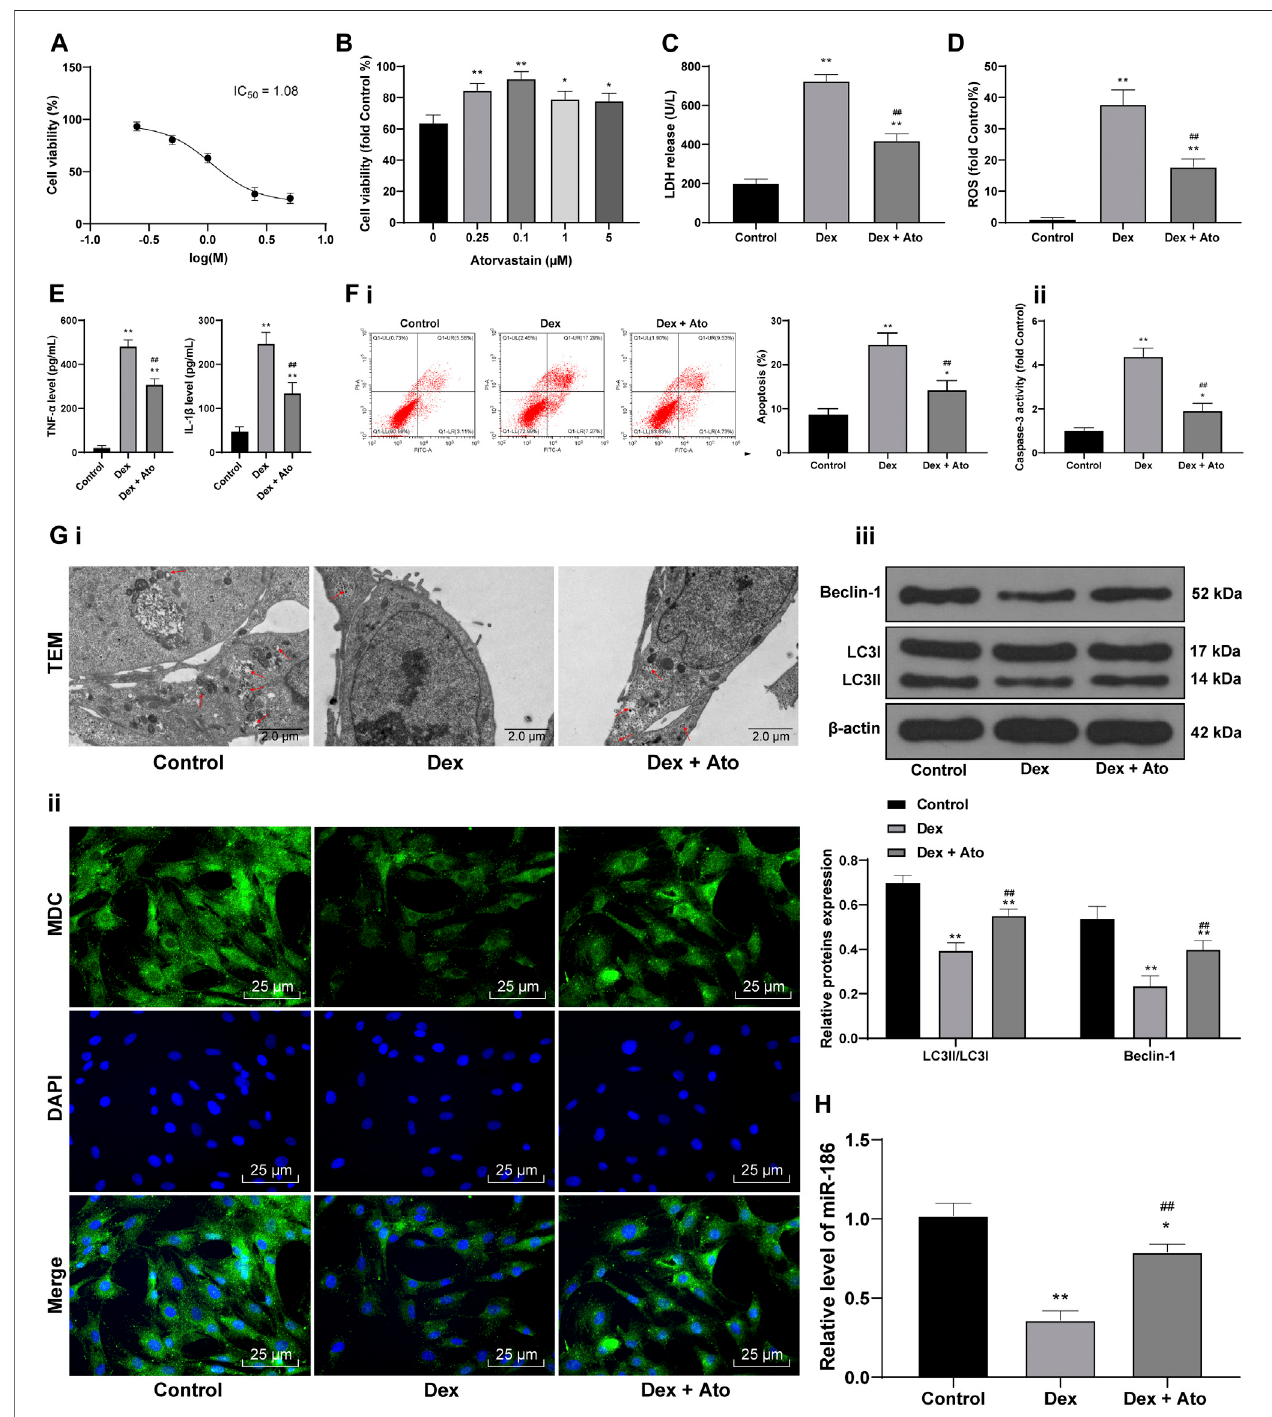
FIGURE5| AtoreducesDEX-inducedosteoblastinjury. (A) MTTassaydetectedOB-6cellviabilityattheconcentrationofDEX; (B) MTTassaydetected1 μ MDEX- treatedOB-6cellviabilityaftertreatmentwithdifferentconcentrationsofAtofor72 h; (C) RelativeLDHreleaseinOB-6cellswasanalyzedbyLDHassaykit; (D) ROSlevel in OB-6 cells was measured by DCFH-DA probe; (E) levels ofin fl ammatory cytokines (TNF- α and IL-1 β ) were detected by ELISA kits; (F) apoptosis of femoralhead was detected by fl ow cytometry (i) and caspase-3 activity test (ii) ; (G) transmission electron microscopy (i) and MDC fl uorescence staining (ii) were used to observe autophagy; (iii) Western blot analysis was used to detect LC3II/LC3I and Beclin-1 expression; (H) RT-qPCR detected miR-186 expression in osteoblasts. Replicates (cid:1) 3. The data are shown in mean ± standard deviation. * p < 0.05, ** p < 0.01, vs. the control group; # p < 0.05, ## p < 0.01 vs. DEX group.